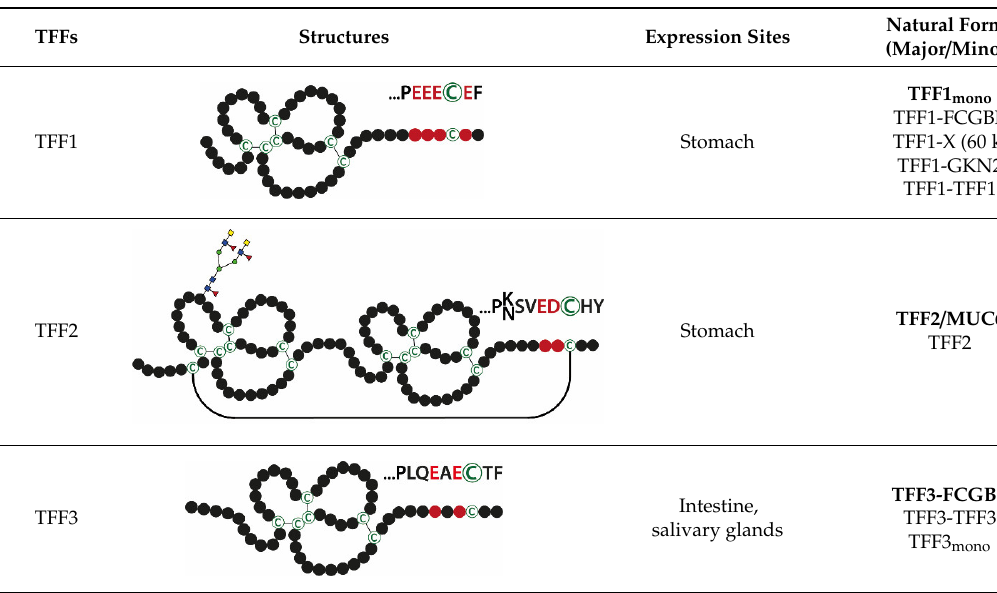
Table 2. Structures and natural forms of human TFF peptides at their predominant expression sites. TFFs Structures Expression Sites